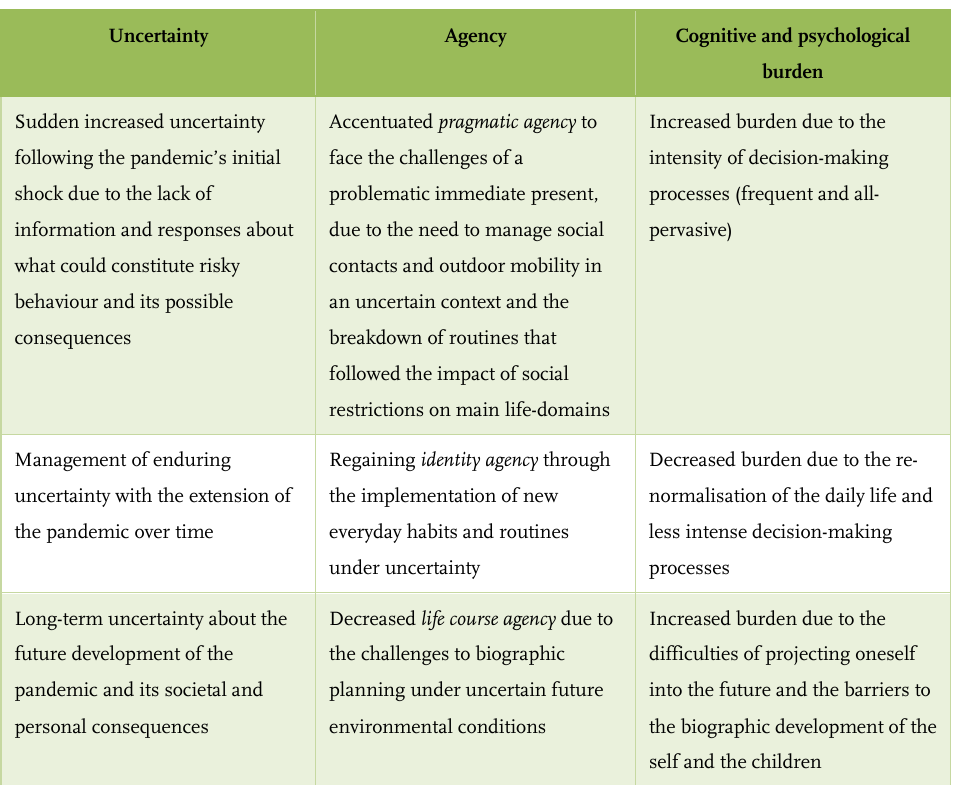
Table 1 : Links between uncertainty, agency and cognitive and psychological burden in